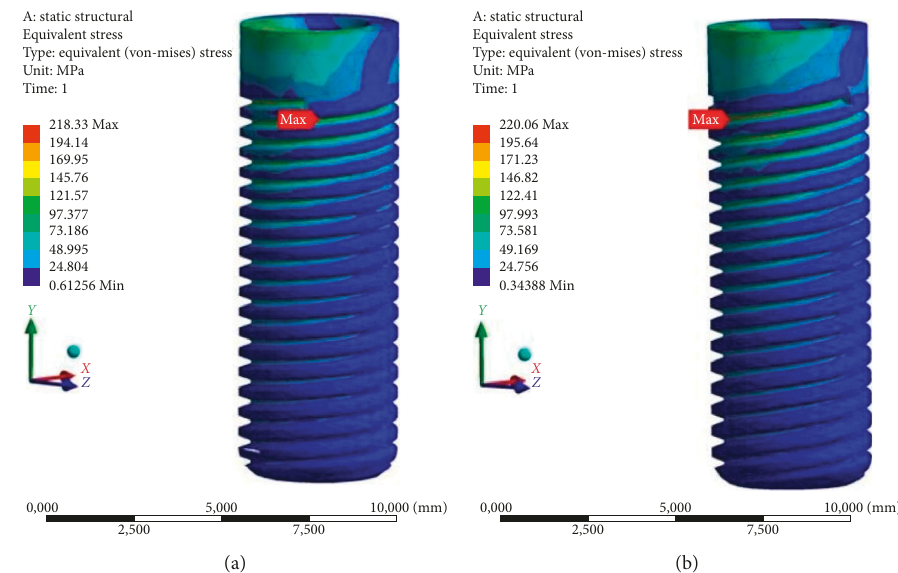
Figure 6: FEA results of implants with 2 threads (a) and 3 threads (b). The implant material is cp Ti with the nanotubular TiO